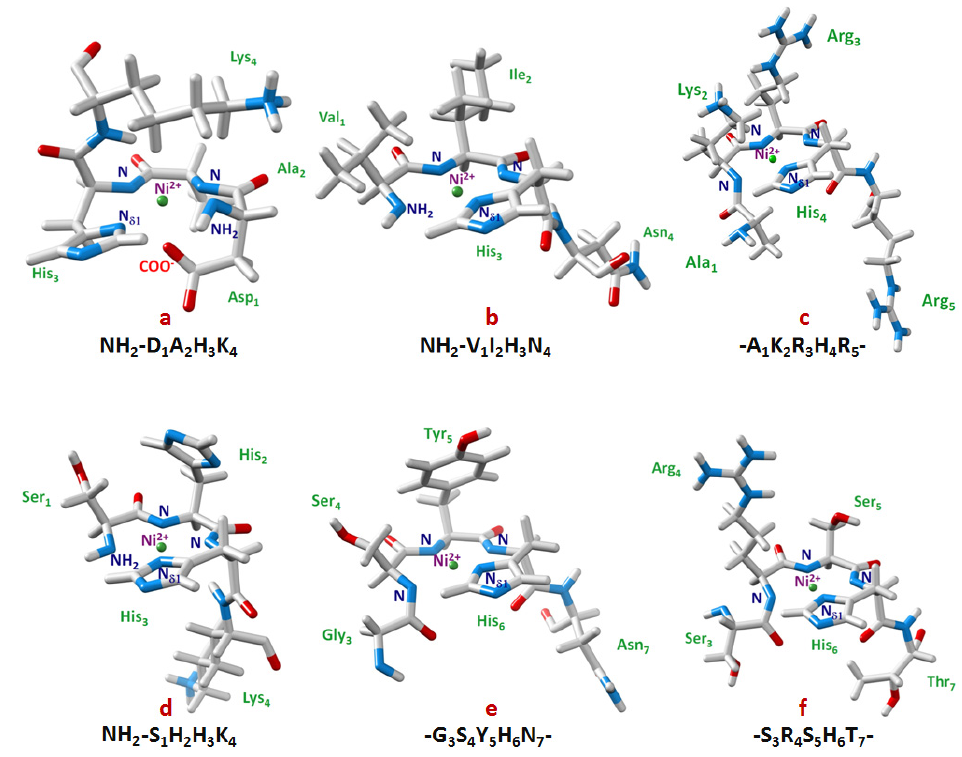
{N , 2N − , NH , O − } with NH -DAHK- fragment from human serum albumin ( a ), and in a Im 2 2 square planar mode with: ( b ) NH -VIHN- from Des-Angiotensinogen {N 2 , 3N − }, ( d ) NH -SHHK from histone H2A {NH ( c ) -AKRHR- from histone H4 {N Im 2 ( e ) -GSYHN- from prion protein {N , 3N − }, ( f ) -SRSHT- from Cap43 protein {N Im Ni(II) is reported in green and the amino acids according to the chemistry of their atoms: in obtained by molecular modeling